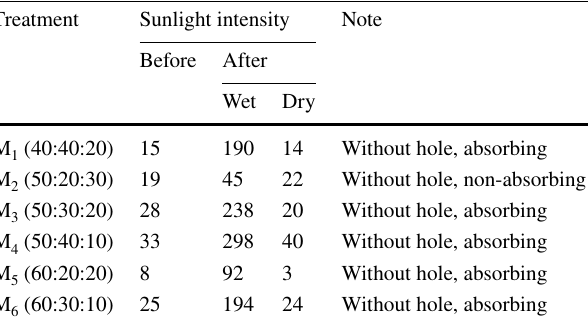
Table 3 The result of vilensky test of various organic mulch y = -0.0764x 2 + 3.1942x - 3.85